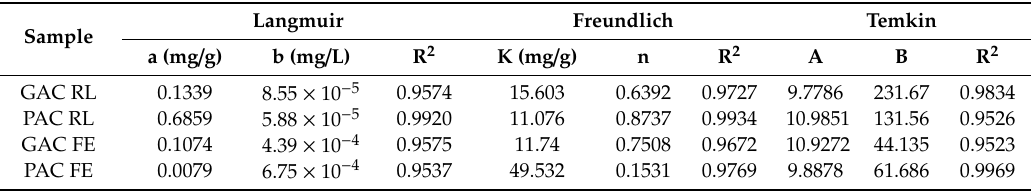
Table 2. Fitted model constants and determination coe ffi cients for adsorption isotherms. R 2 = coe ffi cients of